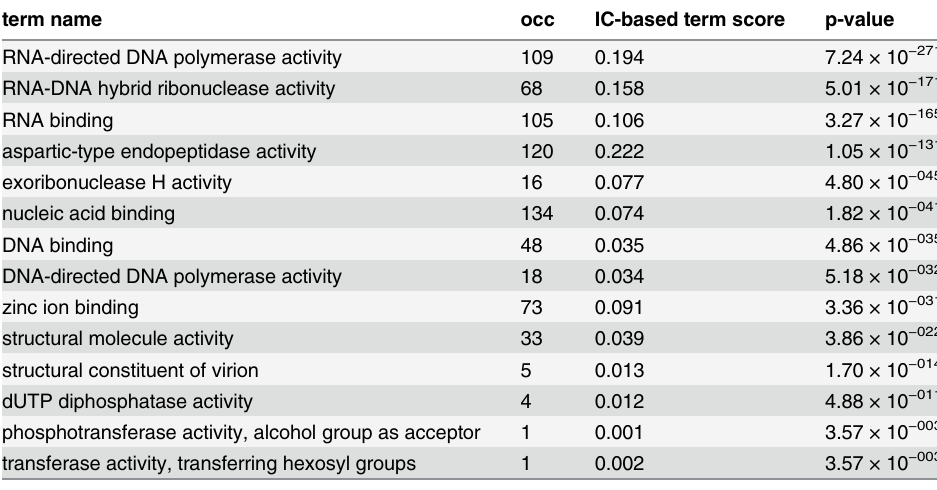
Table 4. Term annotated occurrence (occ) number, IC-based term score and enrichment p-values for the A2 Set signi fi cant terms (alpha = 0.01) while using the complete collection of MEROPS Collection as